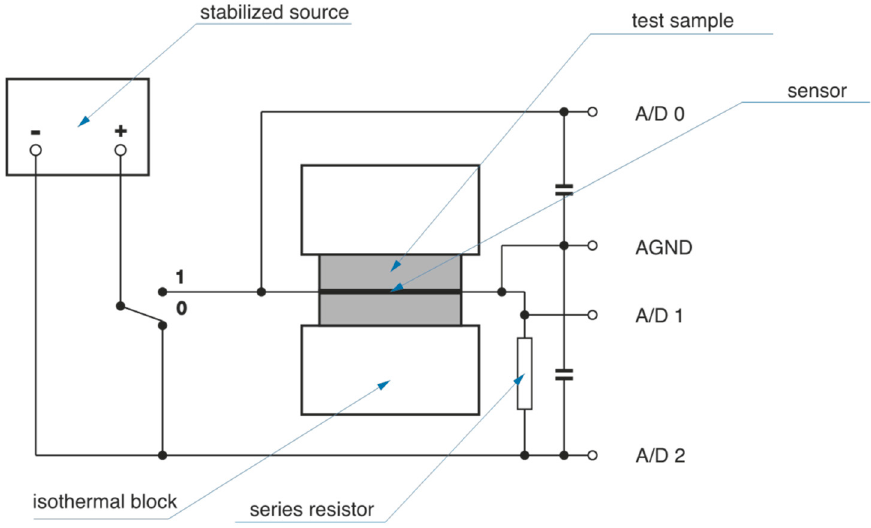
Figure 4. Samples for measurement of thermophysical properties by EDPS method. The EDPS (Extended Dynamic Plane Source) method was used to measure thermo- physical properties. It is one of the non-stationary methods for this purpose [32,33]. The EDPS method is based on the Dynamic Plane Source (DPS) method, andit can be used to investigate the thermal conductivity, thermal diffusivity and specific heat capacity of